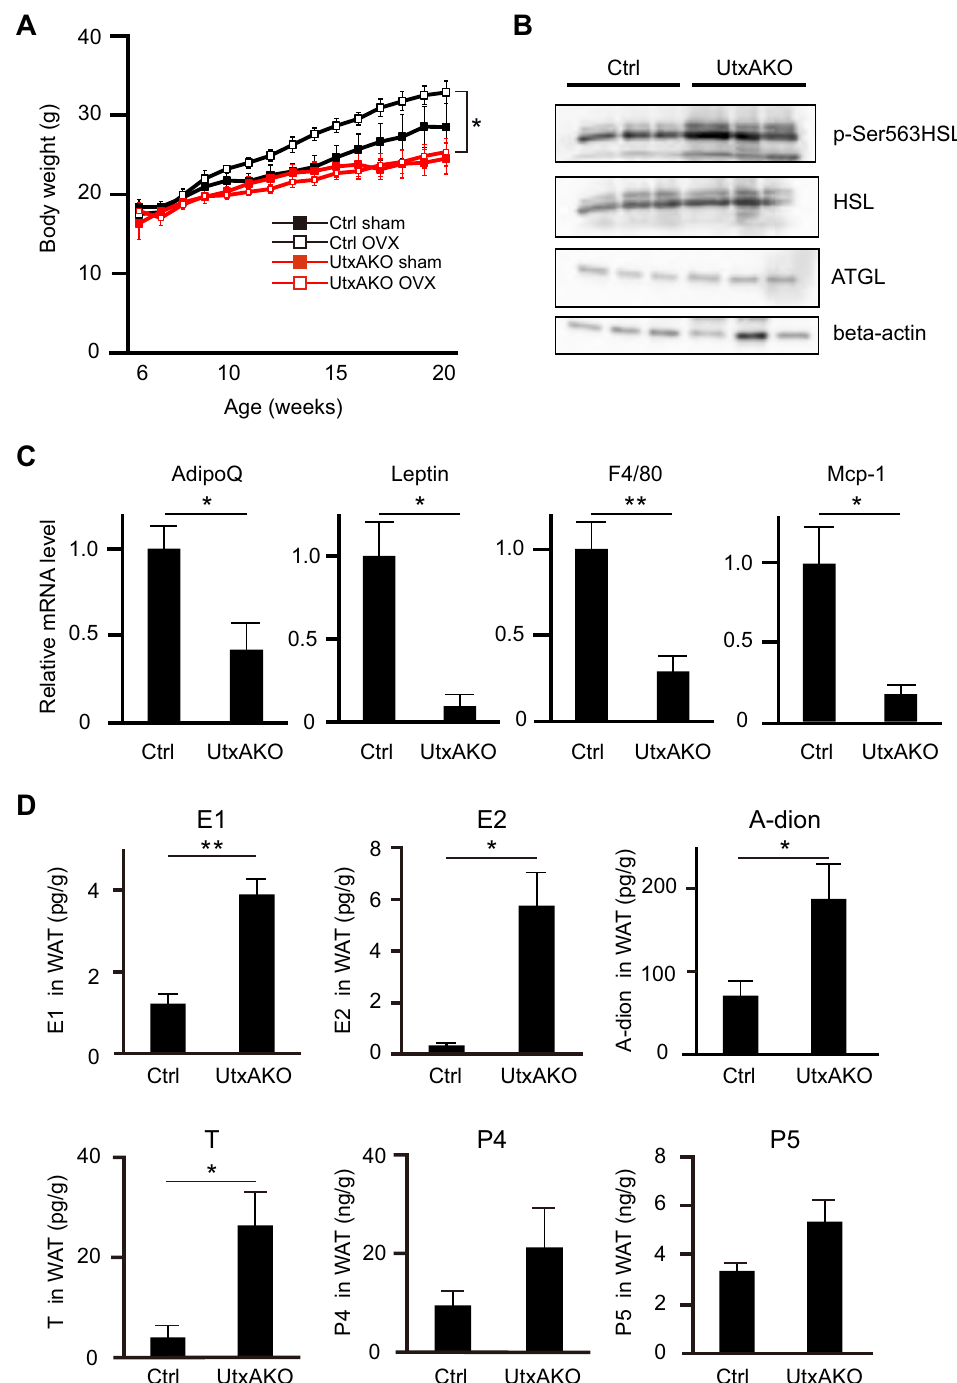
Figure 4. Female UtxAKO mice resist obesity induced by ovariectomy (OVX) and HFD. ( A ) Time course of BW gain in f-HFD-Ctrl and f-HFD-UtxAKO mice that were subjected to sham surgery or OVX at 6 weeks of age ( n = 4/group) and fed on HFD until 20 weeks of age. ( B ) Protein levels of the lipases were examined in visceral WAT of HFD-fed female Ctrl and UtxAKO mice at 20 weeks of age ( n = 3). HSL (hormone-sensitive lipase), phosphor-HSL (Ser563), ATGL (adipose triglyceride lipase), beta-actin. ( C ) Relative mRNA levels of the indicated genes in visceral WAT of f-HFD-Ctrl and f-HFD-UtxAKO mice at 20 weeks of age ( n = 5/group). ( D ) Increased concentrations of E1, E2, A-dion, T, P4, and P5 in visceral WAT of HFD-fed UtxAKO female mice. The concentration of E1, E2, A-dion, T, P4, and P5 in visceral WAT were quantified by mass-spectrometry from HFD-fed Ctrl and UtxAKO mice with OVX at 20 weeks of age ( n = 4). Values in graphs are expressed as mean ± SE. * p < 0.05, ** p <